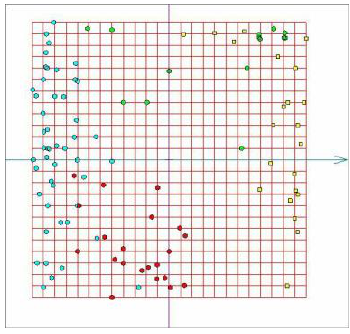
Figure 6. Extension of elastic map for source data